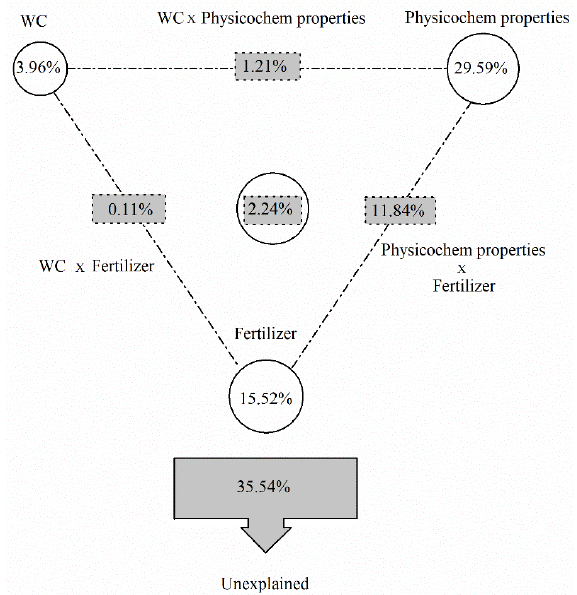
Figure 5. Mantel test and variation partitioning (VPA) analysis of soil physicochemical factors and biogenic factors and the interaction between them and soil water regimes, physicochemical properties, and fertilizer treatments and their interactions. WC—water contents; physicochem properties—physicochemical properties.